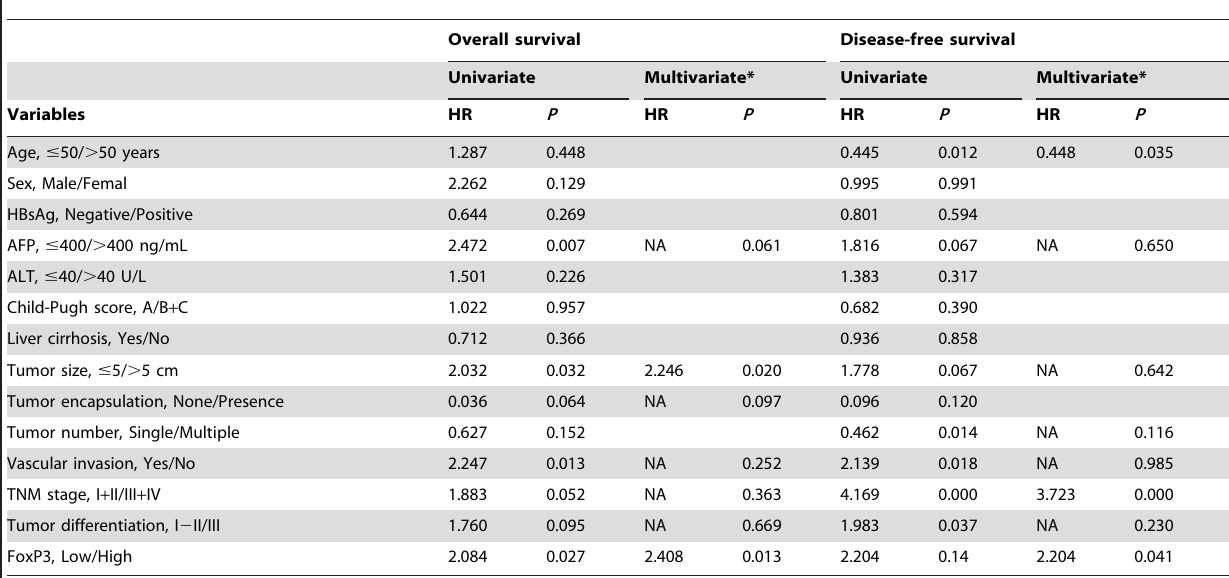
Table 2. Univariate and Multivariate analysis of factors associated with survival and